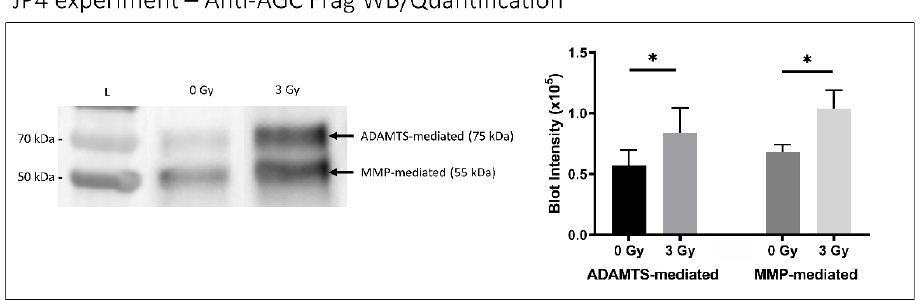
Figure 6. IR treatment increased disc aggrecanolysis in mice. A representative western blot of whole- disc tissue extract showing aggrecan fragments generated from MMP-mediated (55 kDa band) and ADAMTS-mediated (75 kDa band) activities are shown (left) with quantitative band intensity results (right) exhibited. Western blot “L” designates protein ladder with “0 Gy” and “3 Gy” representing radiation treatment dose groups. Data shown as an average of n = 5 with one standard deviation. * p ≤ 0.05.